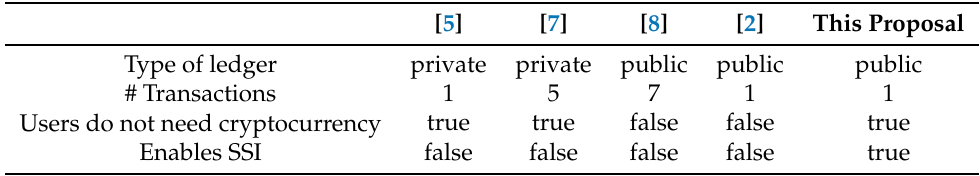
Table 2. Comparison with related